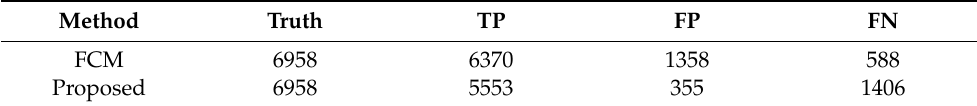
Table 2. Extracted area in average # of pixels (81